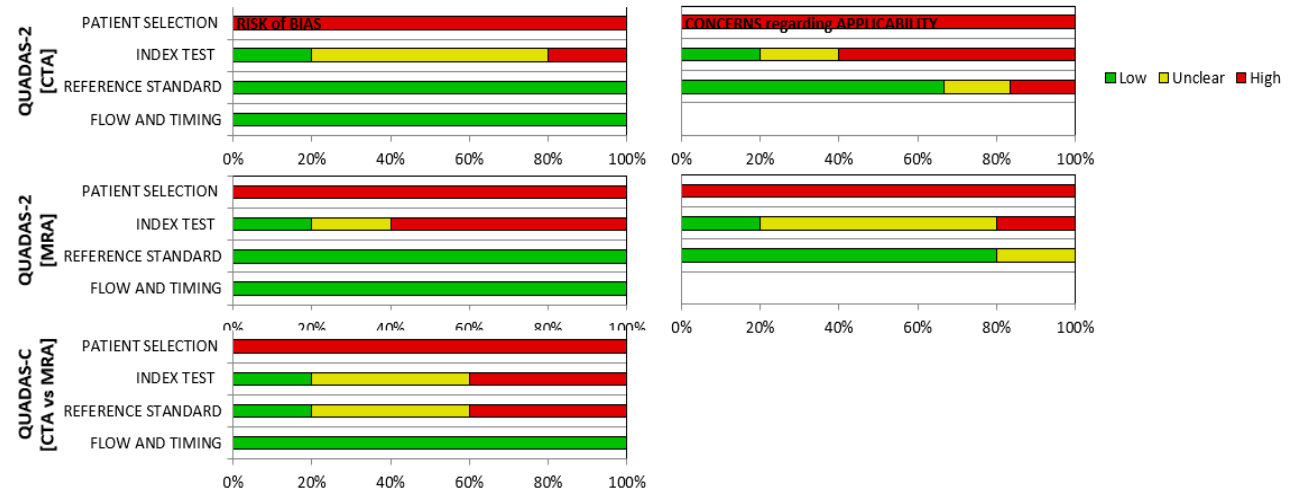
Figure 2. QUADAS-2 and QUADAS-C tools for diagnostic accuracy and risk of bias evaluation in imaging studies. CTA; computed tomography angiography, MRA; magnetic resonance angiography.